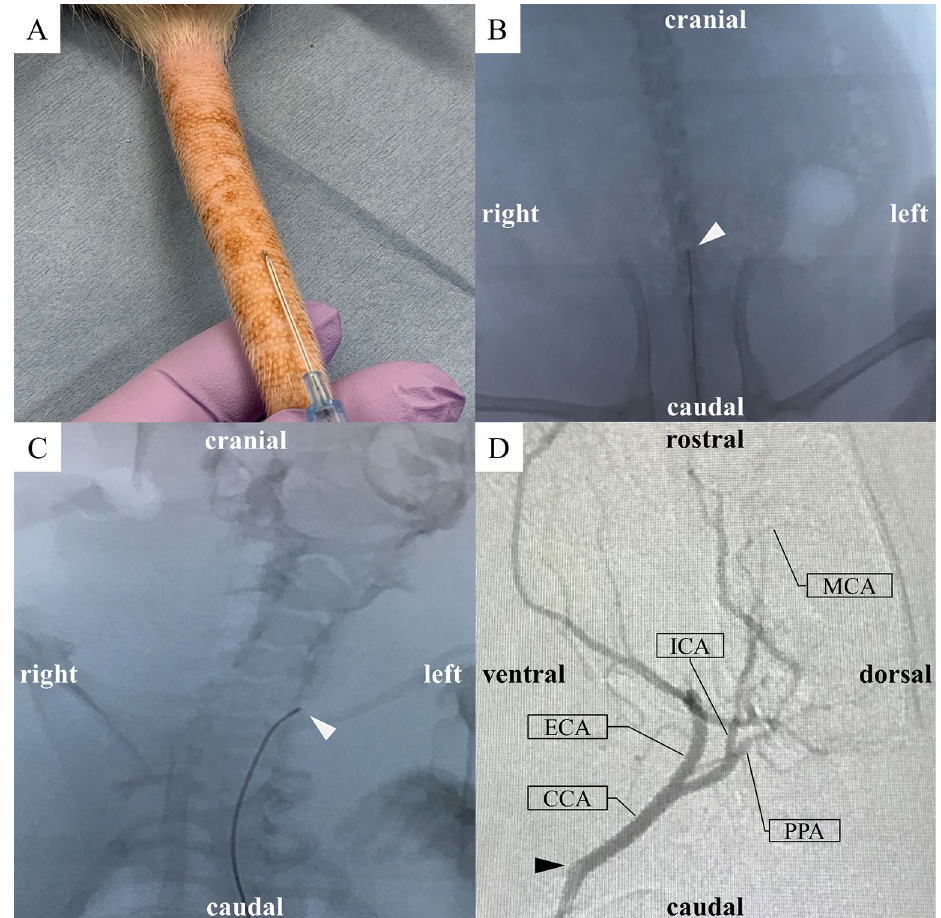
5 cm from the root of the tail, at a sharp angle. ( B,C ) Rat fluoroscopic images of the microcatheter and wire (arrowhead) inserted carefully through the plastic outer indwelling needle, and then inserted into the caudal ventral artery and guided into the abdominal aorta ( B ) and the left CCA ( C ). ( C ) The C-arm was tilted at a 20° LAO angle for easy cannulation of the left CCA. ( D ) Left CCA angiography (LAO angle = 80°). The